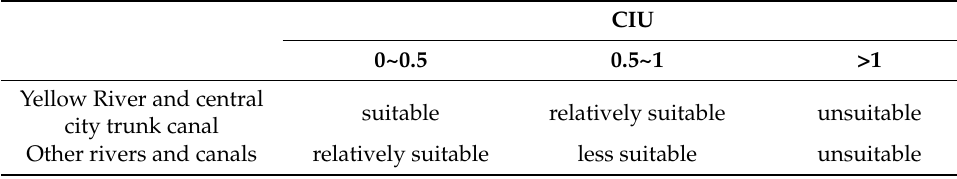
Table 2. WRSU discriminant matrix based on